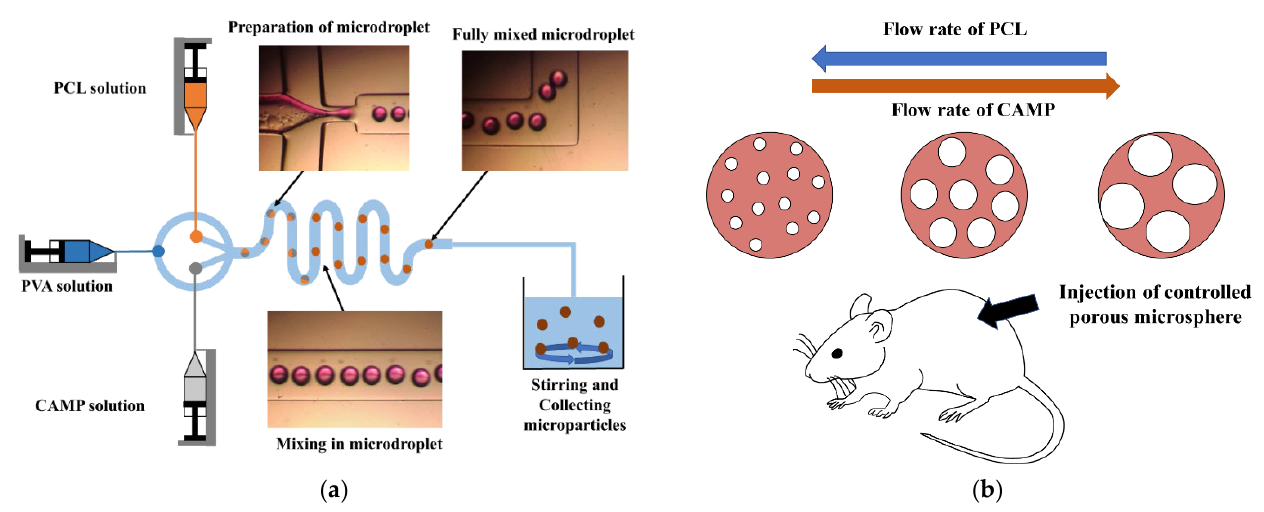
Figure 1. The generation process of highly porous microspheres with controllable pores by the in situ microfluidic system: ( a ) total microfluidic system, ( b ) mechanism for controlling pores of highly porous microspheres by adjusting flow rates and animal test .